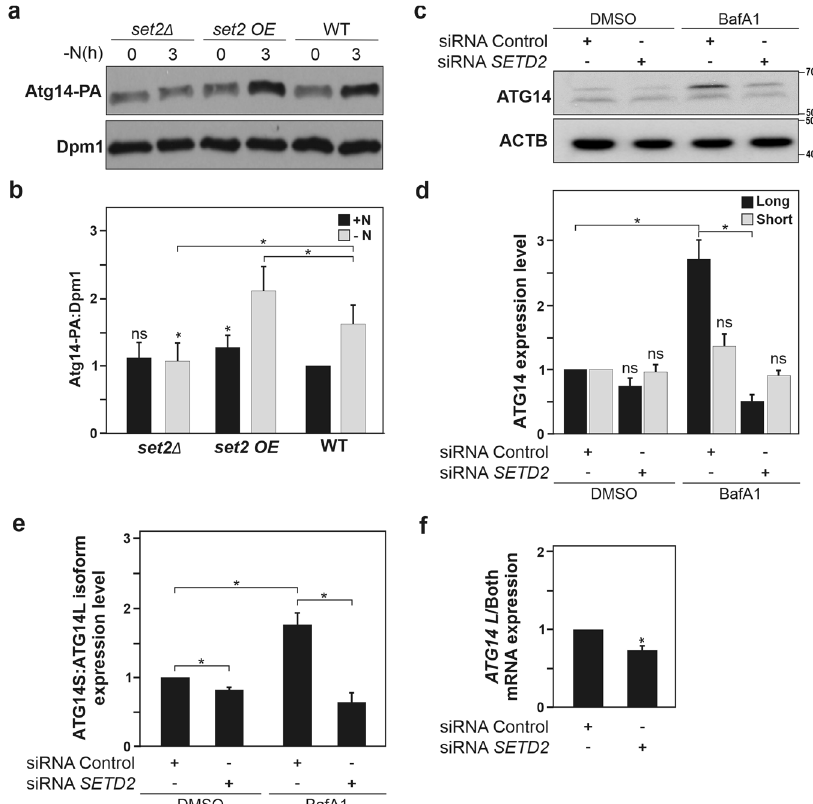
Fig. 4 SETD2 promotes the differential expression of ATG14 protein isoforms. a To analyze Atg14 protein expression in WT (YAB420), set2 Δ (YAB421) and Set2 -overexpressing (OE; YAB422) yeast strains, a protein A (PA) tag was integrated at the chromosomal ATG14 locus. Cells were grown in rich medium conditions ( + N) until mid-log phase and then shifted to nitrogen-starvation medium ( − N) for 3 h. Protein extracts were analyzed by immunoblotting and incubated with antisera that recognize PA for Atg14 detection, and anti-Dpm1 was used as a loading control. Quanti fi cation of the single Atg14-PA protein band expression levels is shown in panel b . c – e HeLa cells were transfected with a control non-targeting siRNA pool or SETD2 siRNA pool for 48 h and thereafter treated with BafA1 for 4 h. c Cells were harvested, and protein extracts analyzed by immunoblotting for ATG14 that revealed the existence of two ATG14 immunoreactive protein bands corresponding to distinct ATG14 protein isoforms (see Fig. 6). ACTB was used as a loading control. d , e Quanti fi cation of the individual isoforms, ATG14 long isoform (ATG14L, upper band) and short isoform (ATG14S, lower band) versus ACTB was performed ( d ) or their ratio, i.e. ATG14S:ATG14L isoforms ( e ) are depicted. f Analysis of ATG14L mRNA expression versus expression of both isoforms ATG14L and ATG14S was analyzed by RT- qPCR using primer sets corresponding to the unique N-terminal domain of ATG14L or recognizing both isoform transcripts. Ct values were normalized with housekeeping genes. Bars display the mean of at least three independent experiments ( a , b and f , n = 4; c and e , n = 5), error bars represent SEM; * P < 0.05, ** P < 0.01, *** P < 0.001, ns: non-signi fi mutant HTT (mHTT) interrupts the process (for review, see ref. [35]). Considering that SETD2 de fi ciency impaired the autophagic fl ux and